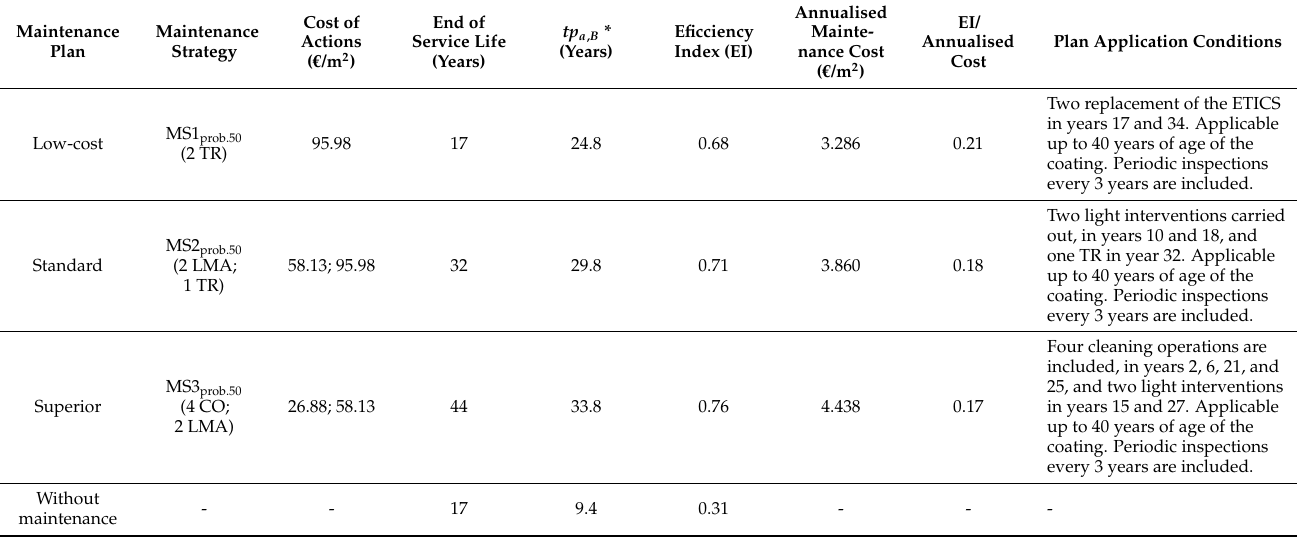
Table 9. Maintenance plans applicable to